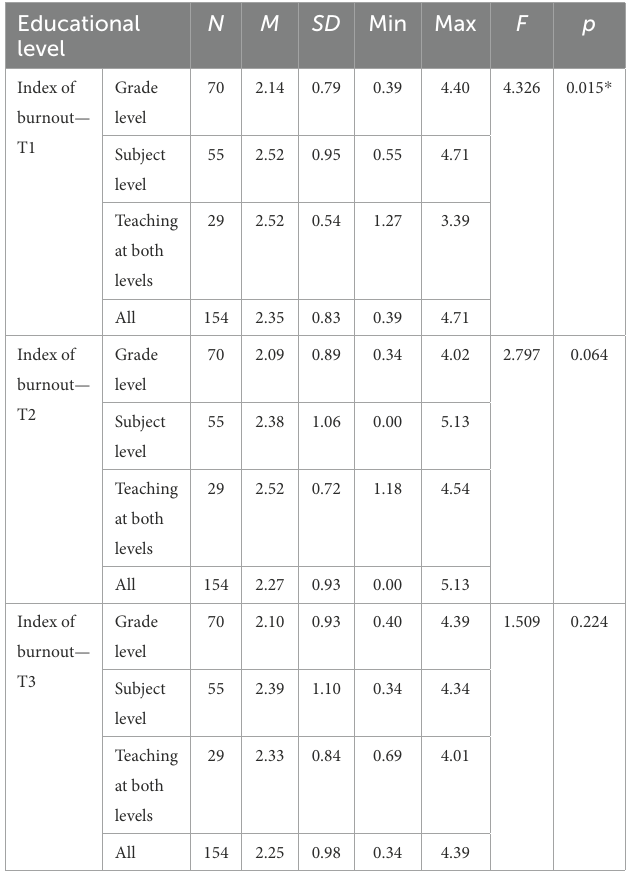
TABLE 8 Descriptive statistics and average comparison of burnout index between teachers at different educational level at three time